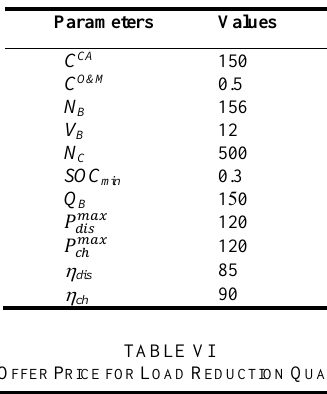
TABLE V E CONOMIC AND T ECHNICAL D ATA OF ES U NIT